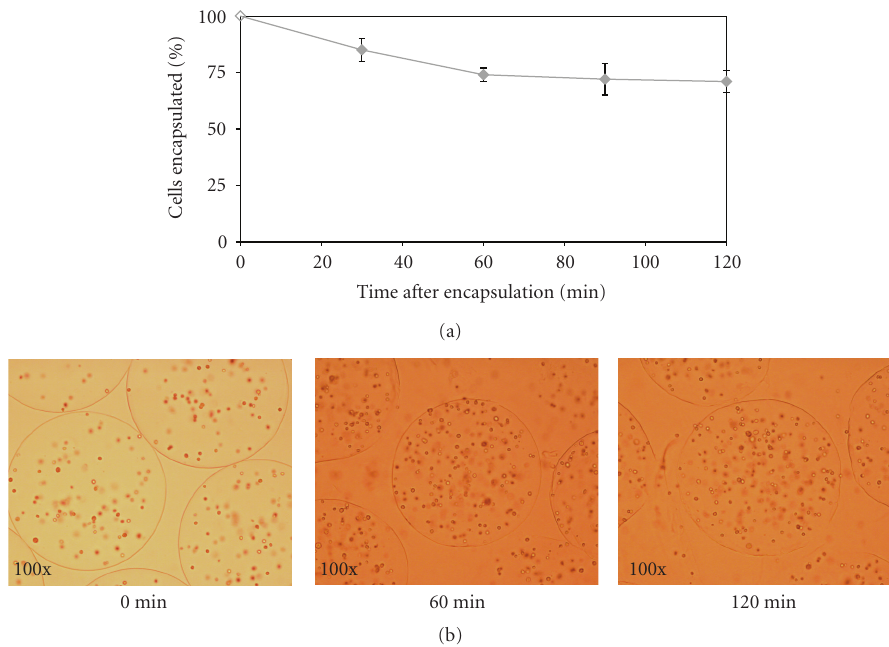
Figure 6: Mechanical and osmotic stability of the AP-PEG-A membrane. The microcapsules prepared by microencapsulating of 2 × 10 6 cells/mL of alginate were subjected to osmotic pressure and rotational stress by rotating them in a hypotonic solution at 150 rpm in a horizontal shaker for 120 min. Samples were collected from time to time; number of free cells were counted in hemocytometer to know the percentage of cells still encapsulated inside the intact microcapsules (a). The data represent the mean of three independent experiments, and error bars represent standard error of the mean. Representative bright field images of the microcapsules encapsulating H9c2 cells under 100x magnifications